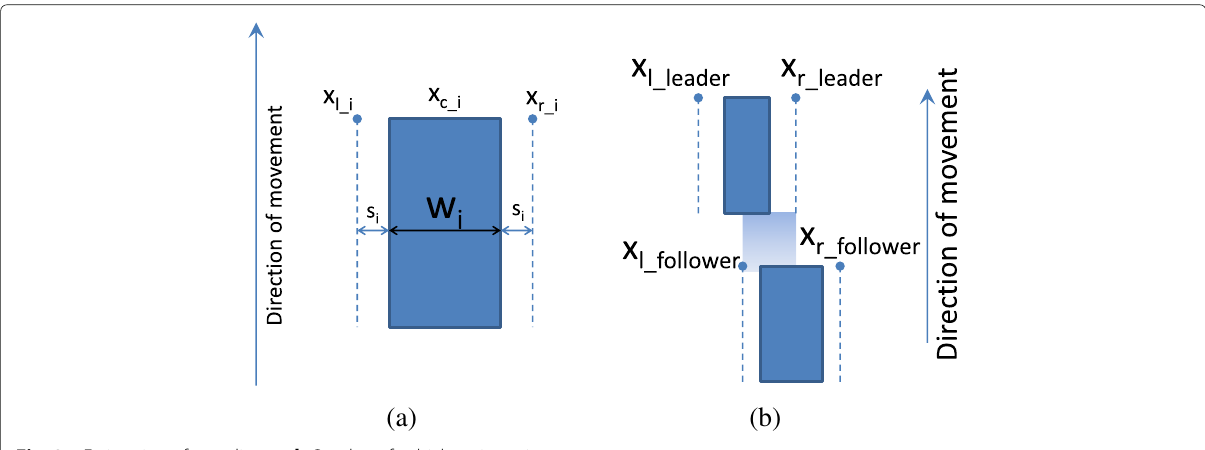
Fig. 3 a Estimation of coordinates, b Overlap of vehicle